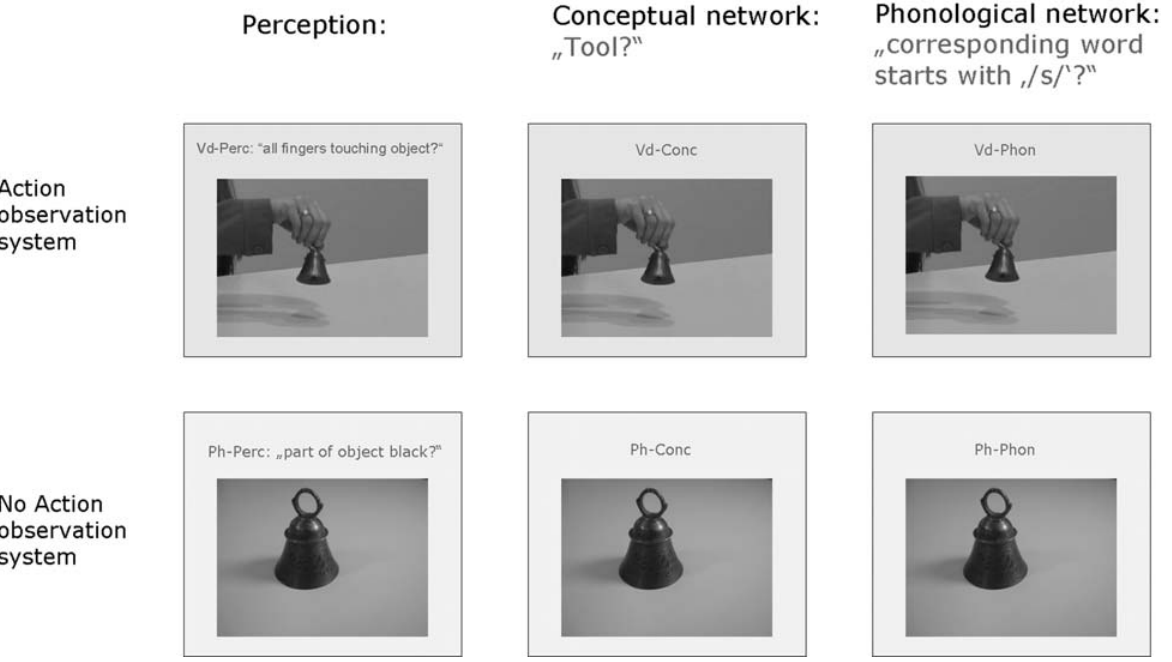
Figure 1. Schematic overview on the experimental design. Identical photo and video stimuli were employed across perceptual tasks (action observation/object perception), conceptual and phonological tasks. Thus differential functional imaging activations were not attributable to stimulus differences.